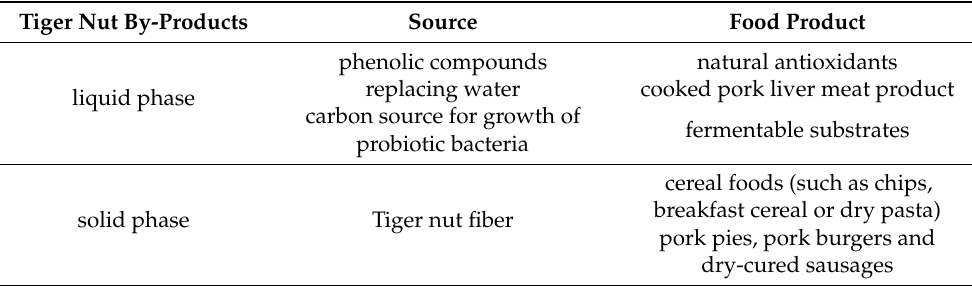
Table 5. Application of tiger nut milk by-products in the food industry. Tiger Nut By-Products Source Food Product phenolic compounds natural antioxidants replacing water cooked pork liver meat product liquid phase carbon source for growth of fermentable substrates probiotic bacteria cereal foods (such as chips, breakfast cereal or dry pasta) solid phase Tiger nut fiber pork pies, pork burgers and dry-cured